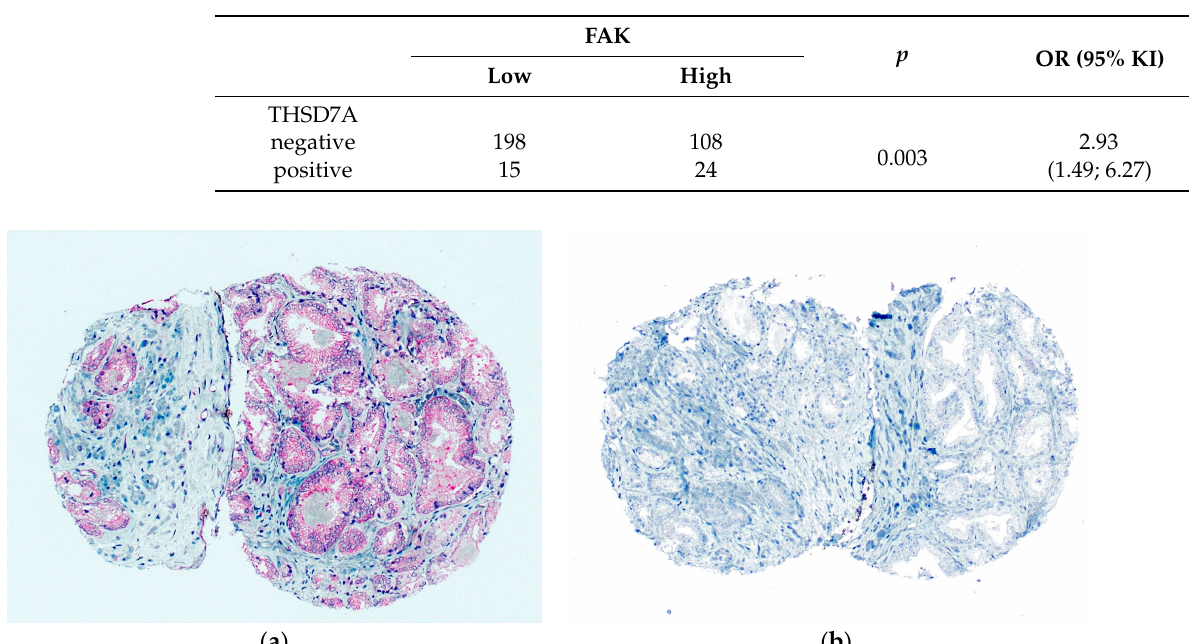
Figure 3. ( a ) Tumor with high FAK expression; ( b ) same tumor is THSD7A-negative with a magnification of 100×.